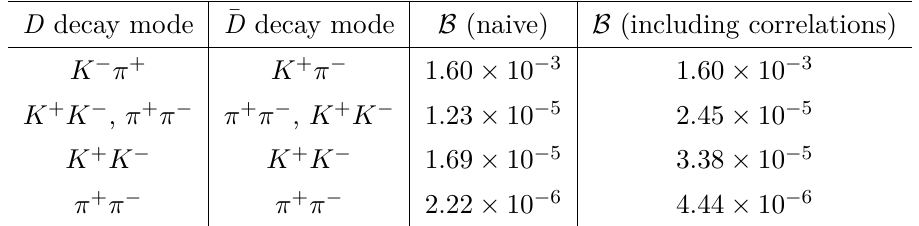
Table 2. Approximate product branching fractions B of a C = +1 D 0 D 0 pair reconstructed in the corresponding D ¯ D decay mode, both under the naive expectation [64] and after the effects of quantum correlation [4, 28], excluding small effects due to charm mixing and ignoring doubly- Cabibbo suppressed